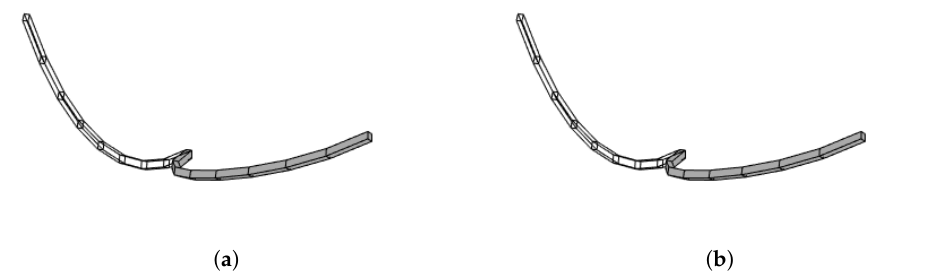
Figure 4. Curved cantilever beam: deformed configuration and tip displacement for assigned load and for assigned strain field. ( a ) Assigned load, tip displacement u 2 = 53.467; ( b ) assigned strain, tip displacement u 2 = 53.467.